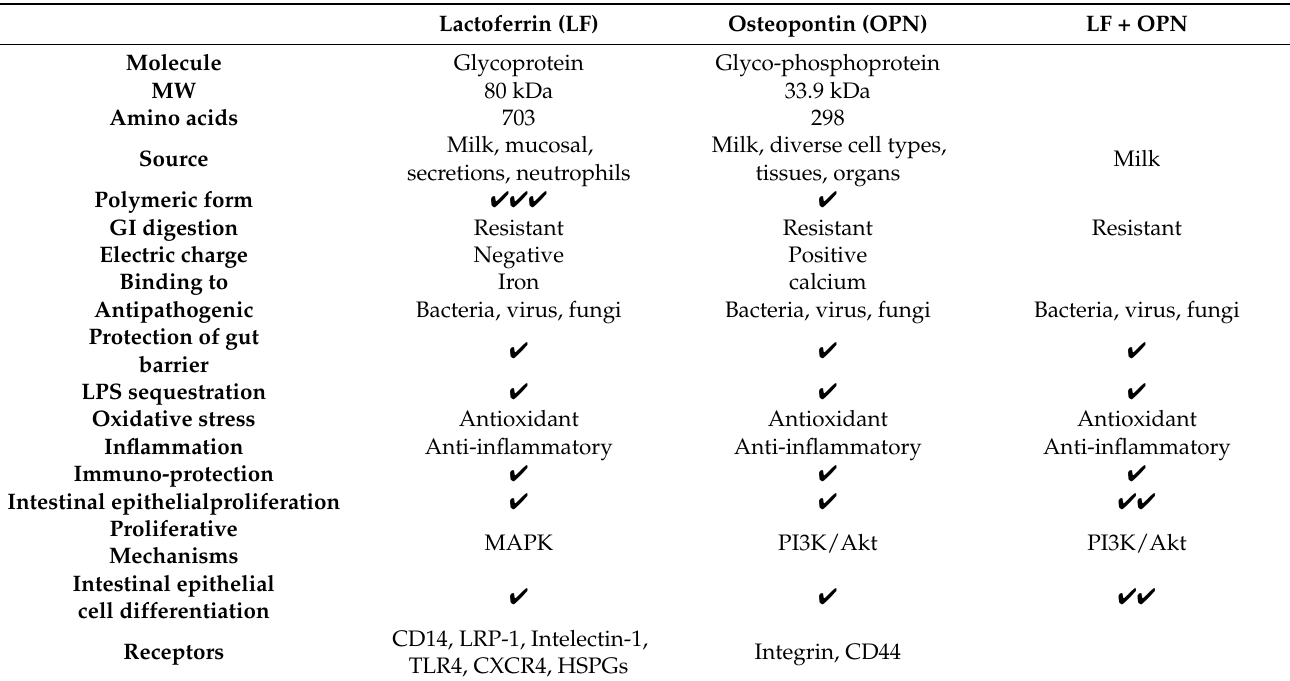
Table 1. Characteristics of lactoferrin, osteopontin, and lactoferrin–osteopontin complex. Lactoferrin (LF) Osteopontin